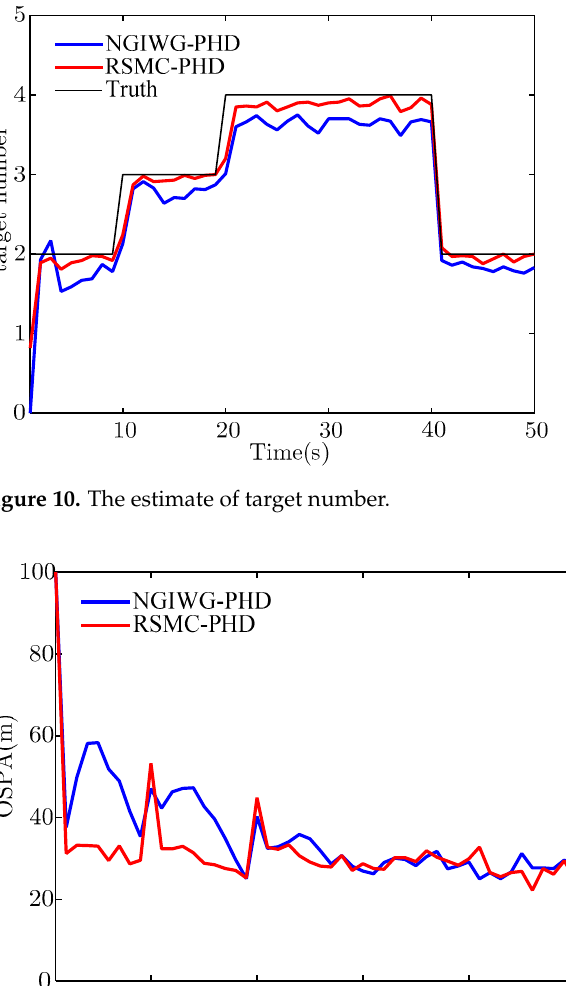
Figure 9. Trajectories of the targets.